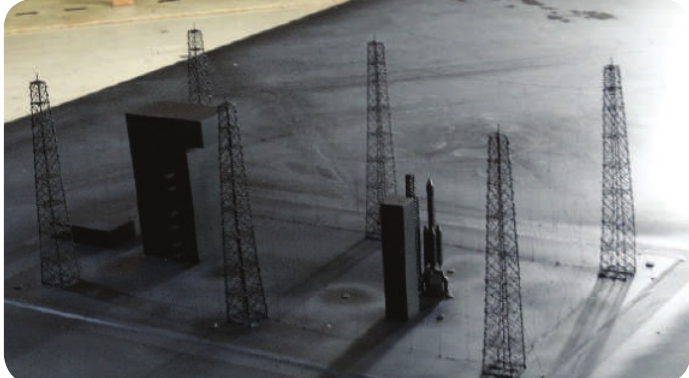
Figure 8. LPA Figure 8. LPA model.